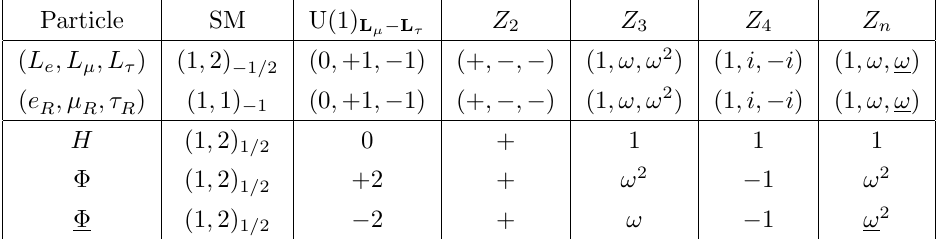
and Z n (cid:13)avor symmetries. The quantum (cid:22) (cid:0) L (cid:28) (cid:0) (cid:1) SU(3) c ; SU(2) L . For abelian discrete U(1) Y